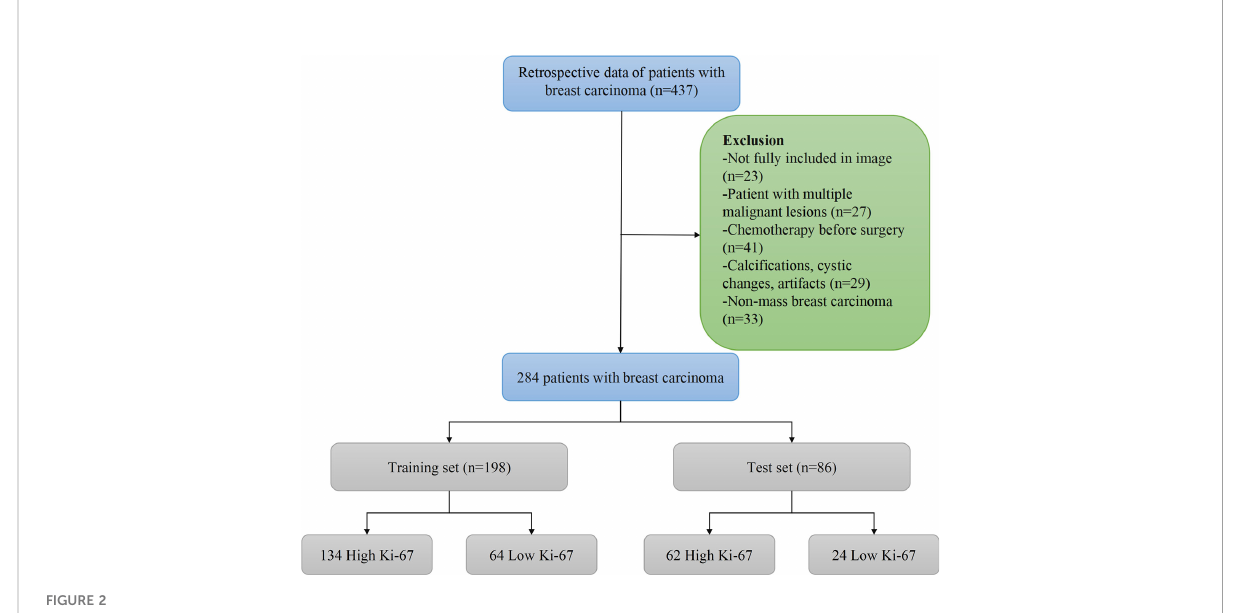
FIGURE 2 The patient enrollment process for this